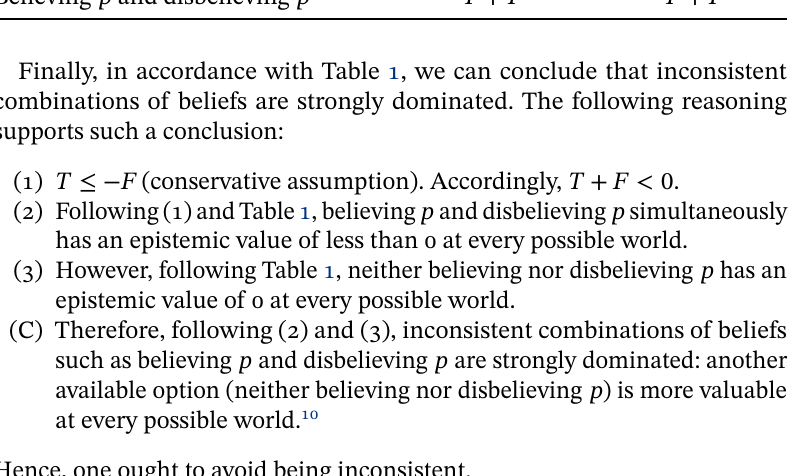
Table 1: An agent’s doxastic options with respect to 𝑝 Doxastic options / possible world 𝑝 is true 𝑝 is false Believing 𝑝 and not disbelieving 𝑝 𝑇 𝐹 Disbelieving 𝑝 and not believing 𝑝 𝐹 𝑇